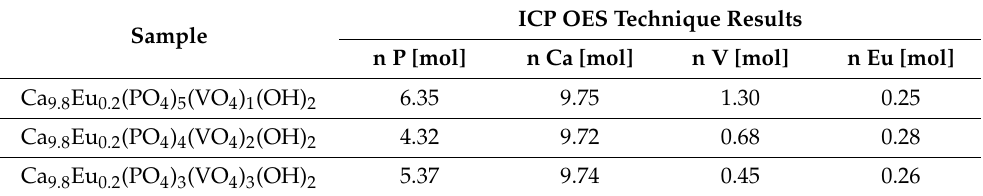
Figure 3. TEM and SAED images of ( a ) Ca 9.8 Eu 0.2 (PO 4 ) 5 (VO 4 ) 1 (OH) 2 , ( b ) Ca 9.8 Eu 0.2 (PO 4 ) 4 (VO 4 ) 2 (OH) 2 , and ( c ) Ca 9.8 Eu 0.2 (PO 4 ) 3 (VO 4 ) 3 (OH) 2 . Table 1. The element contents in the Ca 9.8 Eu 0.2 (PO 4 ) 5 (VO 4 ) x (OH) 2 (where x 1–3) based on the ICP-OES